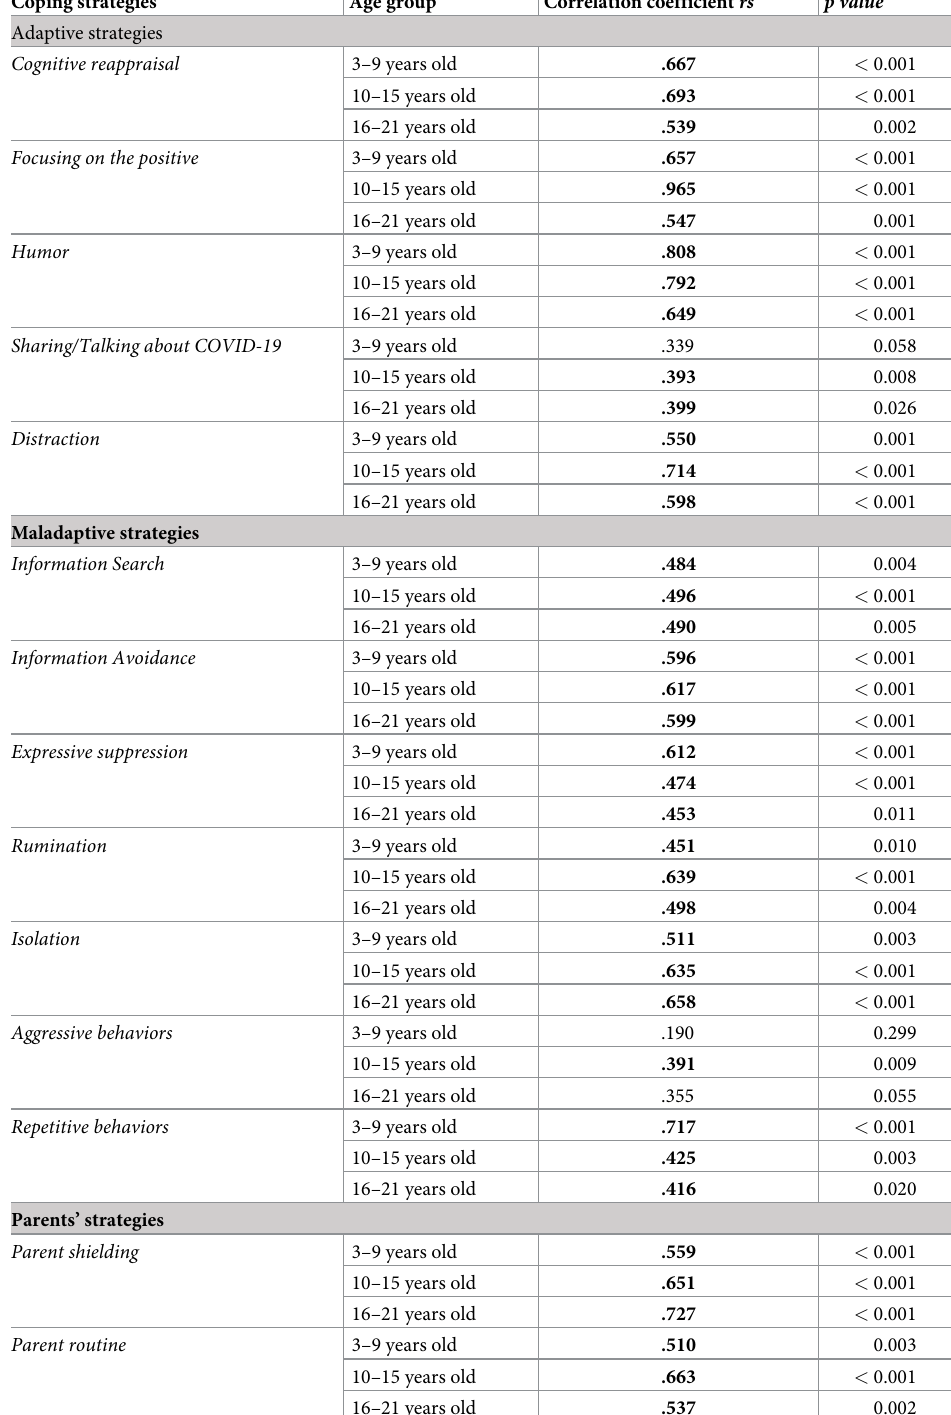
Table 7. Spearman’s rank order correlation coefficients for coping